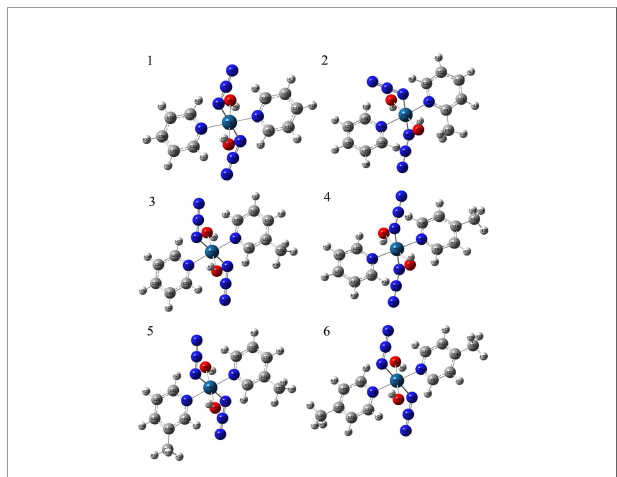
FIGURE 2 | The optimized structure of compounds 1, 2, 3, 4, 5 and